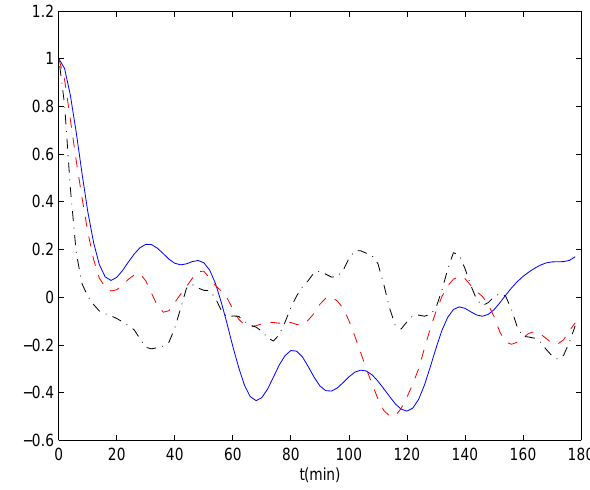
Fig. 12. Autocorrelations of maximal tangential winds (blue), max- imal outflow winds (red), and maximal updraft winds (black).